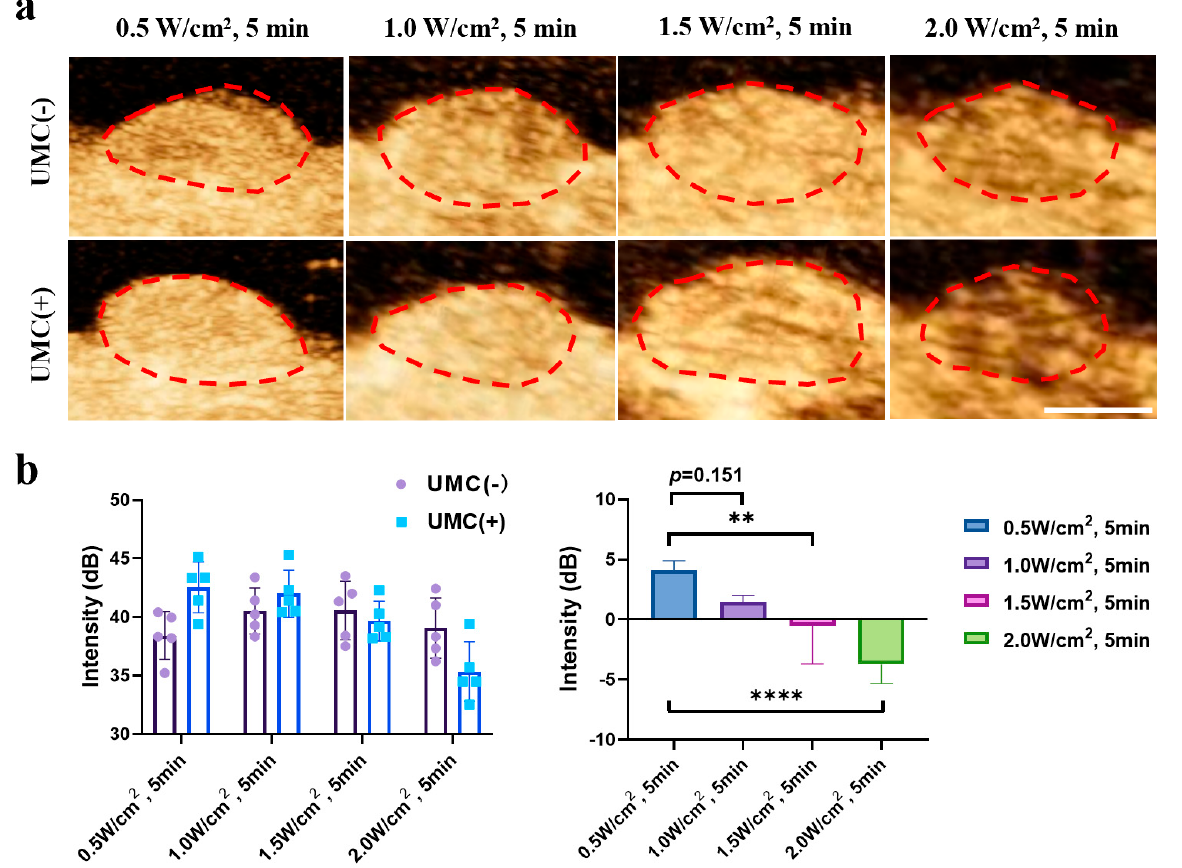
Figure 4. Assessment of UMC-induced changes in tumor perfusion. ( a ) The intra-tumoral perfusion of MDA-MB-468 tumor-bearing mice was assessed via CEUS pre- and post-treatment. ( b ) PI values from pre- and post-treatment CEUS analyses. Data are means ± standard deviation ( n = 5). ** p < 0.01, **** p < 0.0001. Scale bar: 5 mm. UMC(+) = with ultrasound-mediated cavitation, UMC( − ) = without ultrasound-mediated cavitation.